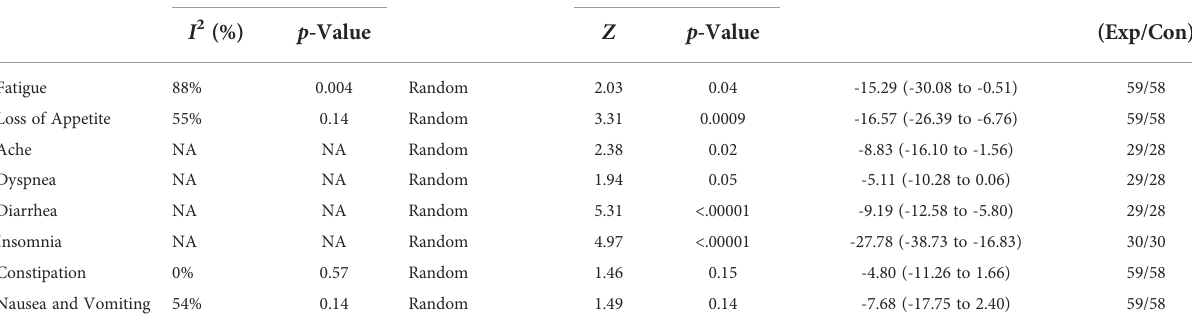
TABLE 4 Karnofsky performance tatus scale * .